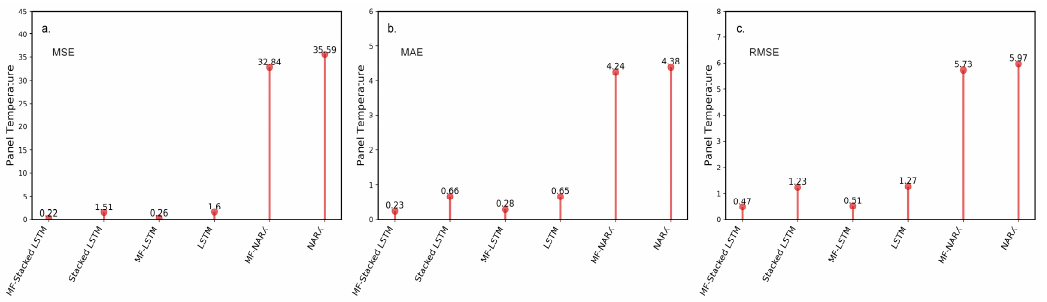
Figure 5. The resulting mean squared error (MSE), mean absolute error (MAE), and root-mean- error (RMSE) with di ff erent approaches for the panel temperature. ( a ) The results for the MSE; square error (RMSE) with different approaches for the panel temperature. ( a ) The results for ( b ) The results for the MAE; ( c ) The results for the the MSE; ( b ) The results for the MAE; ( c ) The results for the RMSE. Similar to the panel temperature, we evaluate the MF algorithm on operating voltage data.